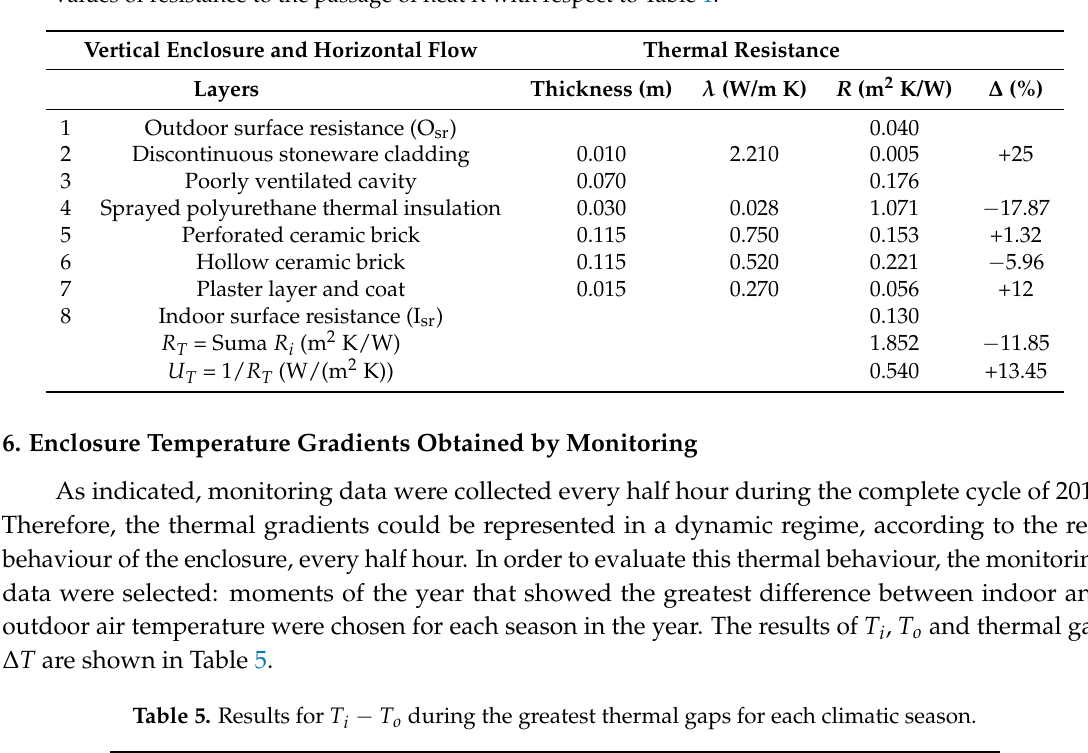
Table 4. U-value according to λ values obtained using Mathis TCi equipment. Percent difference of values of resistance to the passage of heat R with respect to Table 1.